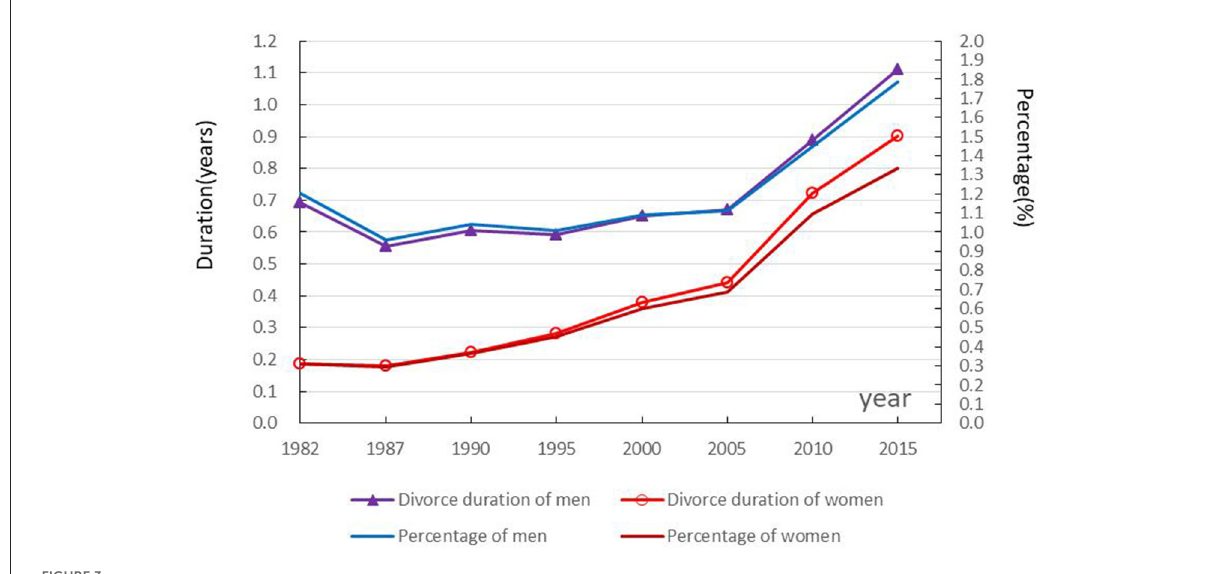
FIGURE3 Trends in divorce duration and proportion among